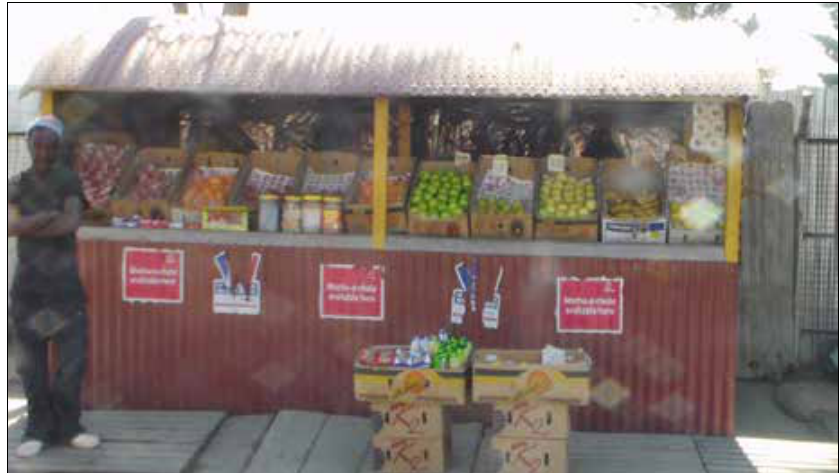
Figure 3: Informal trading in semi-permanent structures focused on workers in AGOA